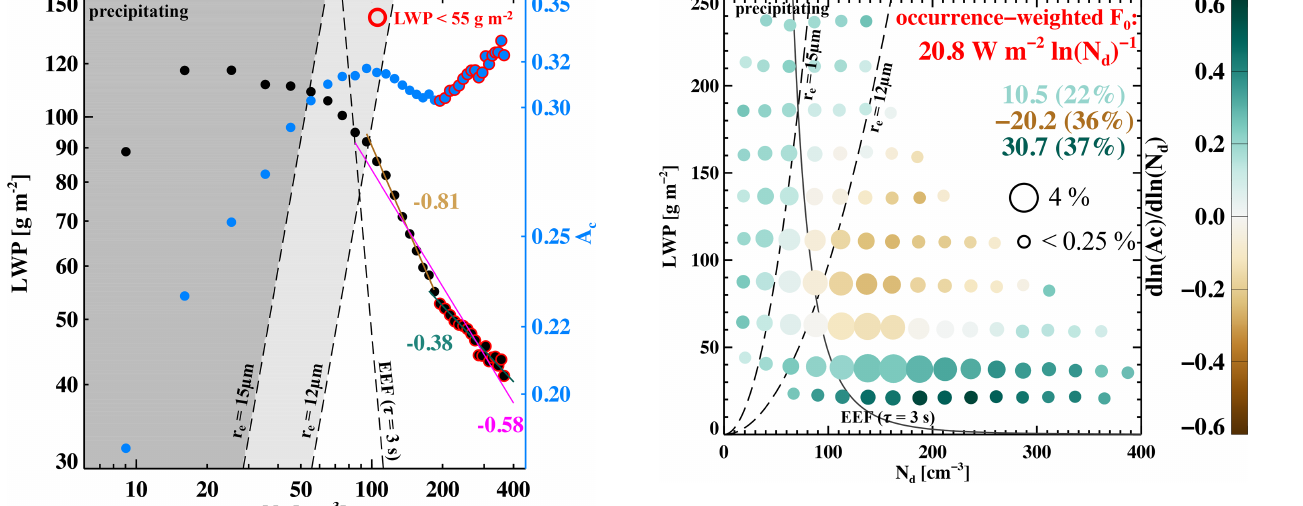
Figure 3. Cloud albedo susceptibility ( S 0 , colored filled circles) in LWP– N d space, as bin means (bin size of 25gm − 2 and 25cm − 3 ). Isolines of r e of 12 and 15µm (black dashed) and EEF (as in Fig. 2) are indicated. Size of the filled circles in each panel indicates the relative frequency of occurrence of each bin (reference circle sizes with corresponding occurrence are indicated). Mean radiative sus- ceptibility ( F 0 ) weighted by the frequency of occurrence of each LWP– N d bin is printed in red (named occurrence-weighted F 0 ), un- der which is a decomposition of F 0 into precipitating–brightening (light green; positive susceptibility states with effective radii greater than 12µm), entrainment–darkening (brown; negative susceptibil- ity states and right-hand side of the EEF isoline), and Twomey– brightening (dark green; non-precipitating states with positive sus- ceptibilities) regimes, with the occurrence of each regime in paren-